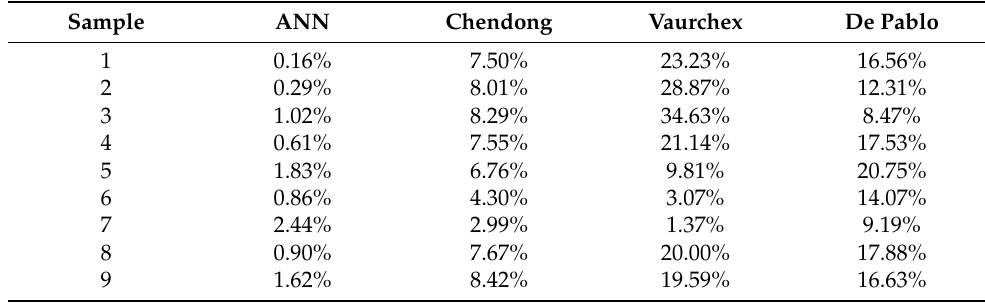
Table 3. Transformer case studies: Error margin.